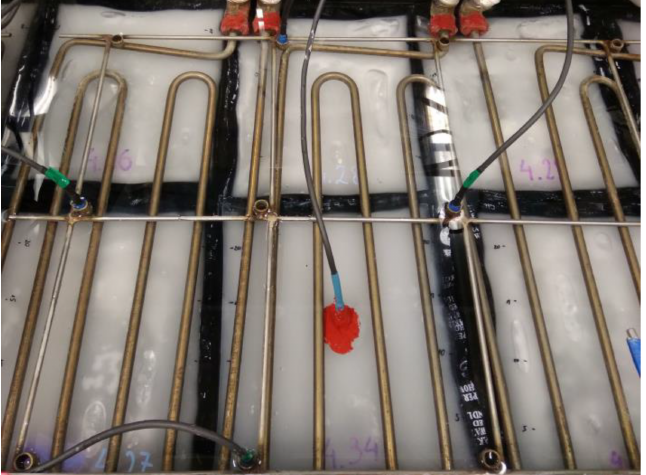
Figure 1. Bags (Type 1) filled with the phase-change materials and placed in the solar still under the electric